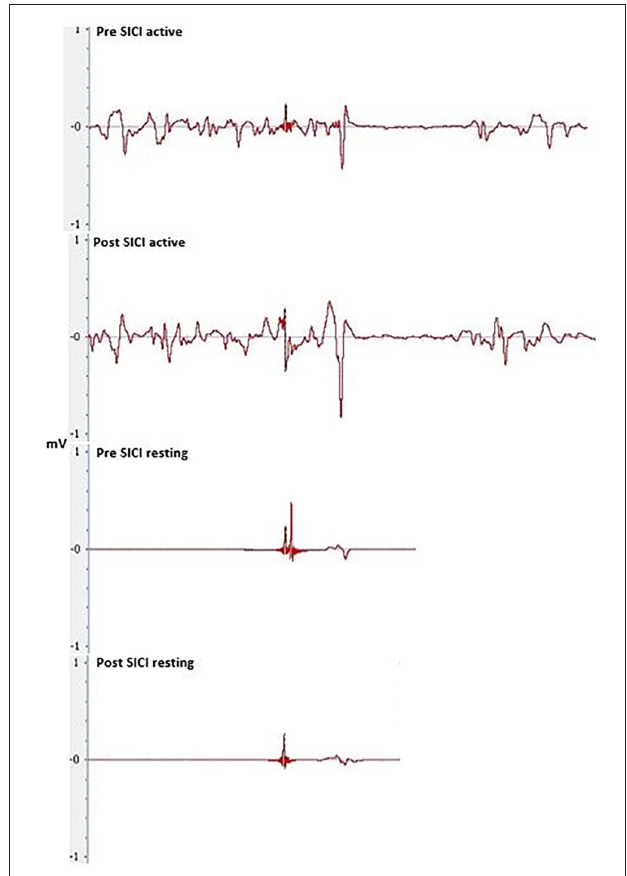
FIGURE 8 | Pre and post-tDCS MEPs elicited through SICI during resting and active conditions.